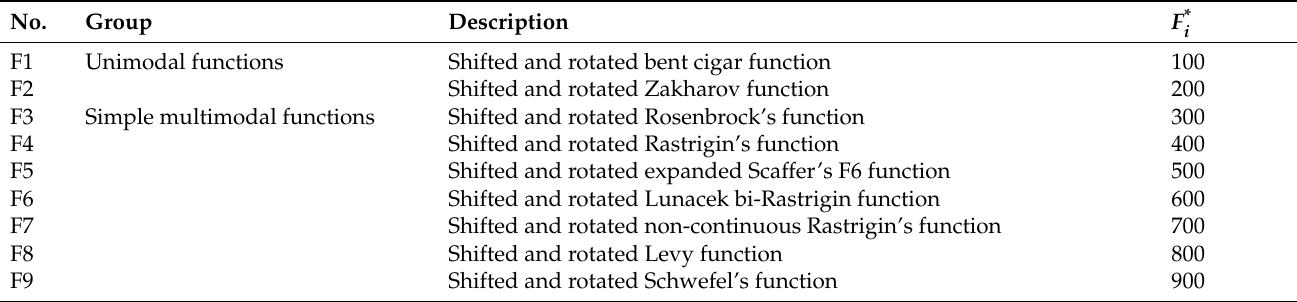
Table 2. Descriptions of the CEC 2017 benchmark functions.